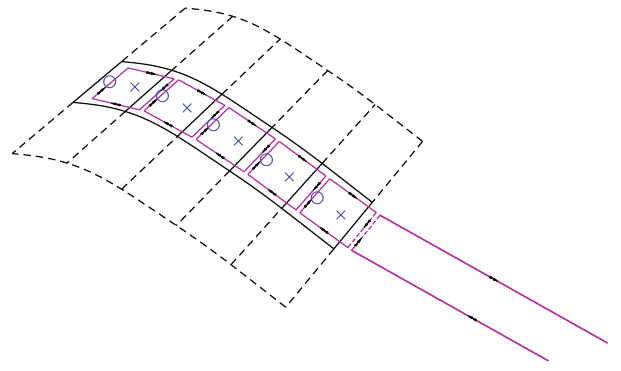
Figure 2: Arrangement of the vortex ring